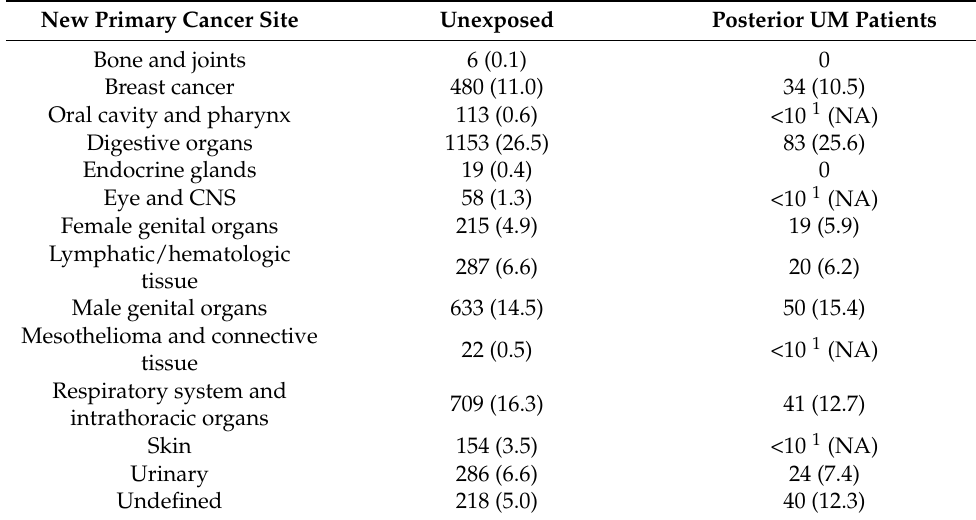
Table 3. Events of new primary cancer specified on cancer type.